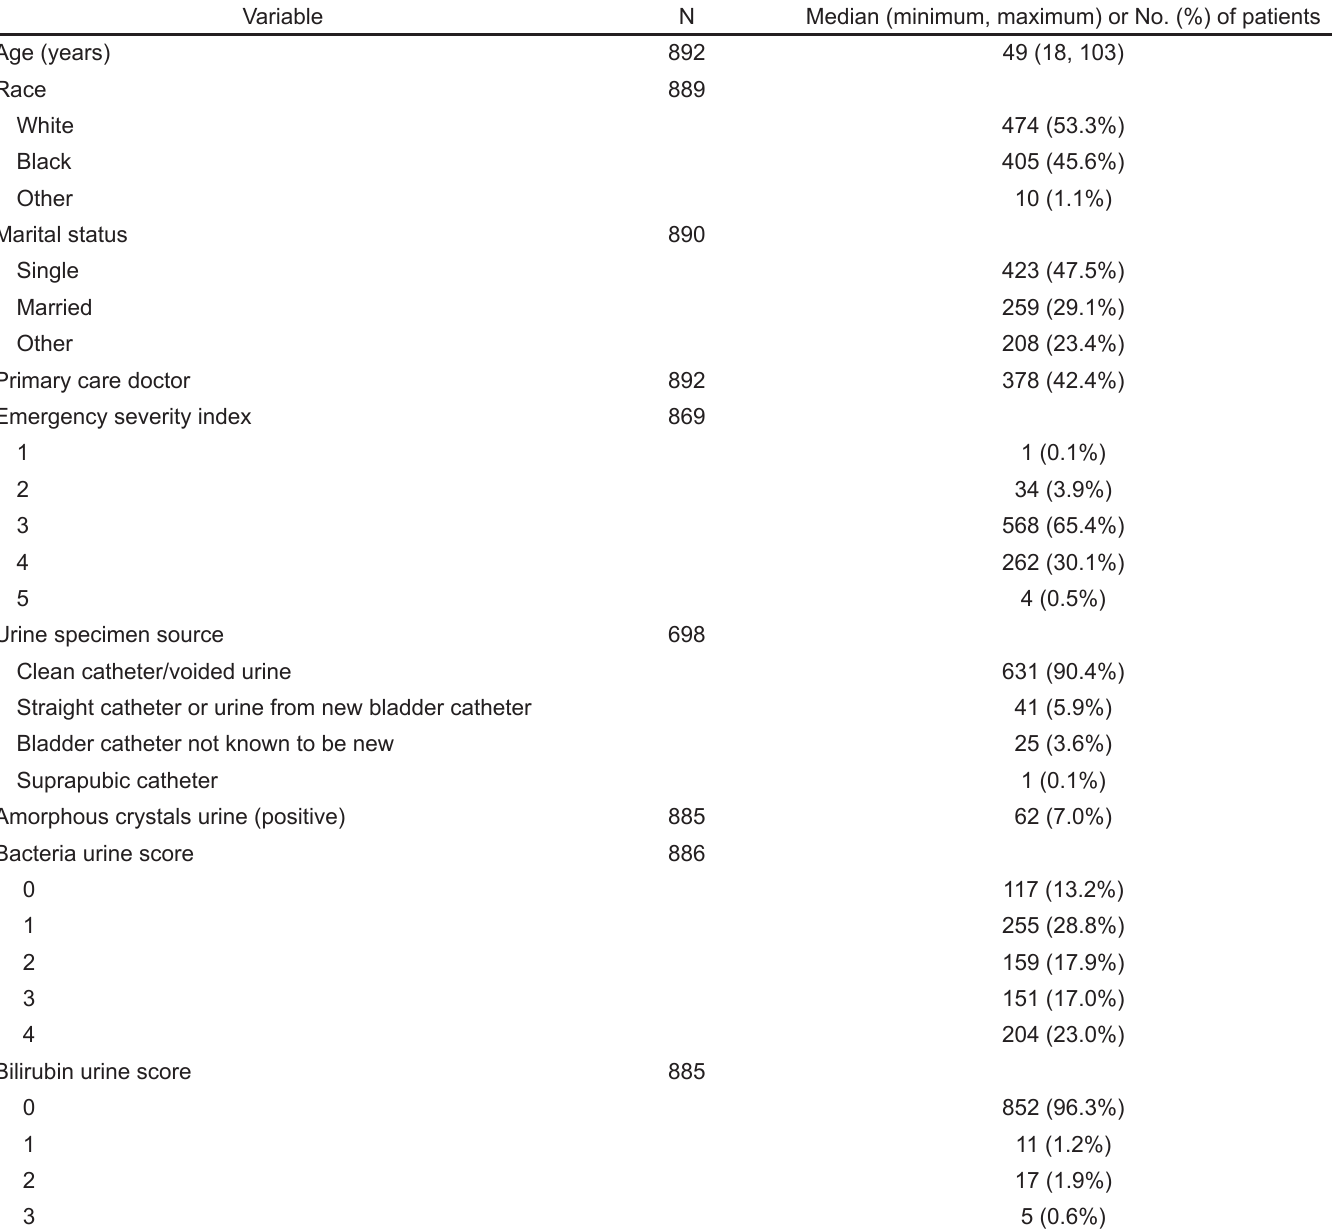
Table 1. Summary of patients characteristics in 892 women